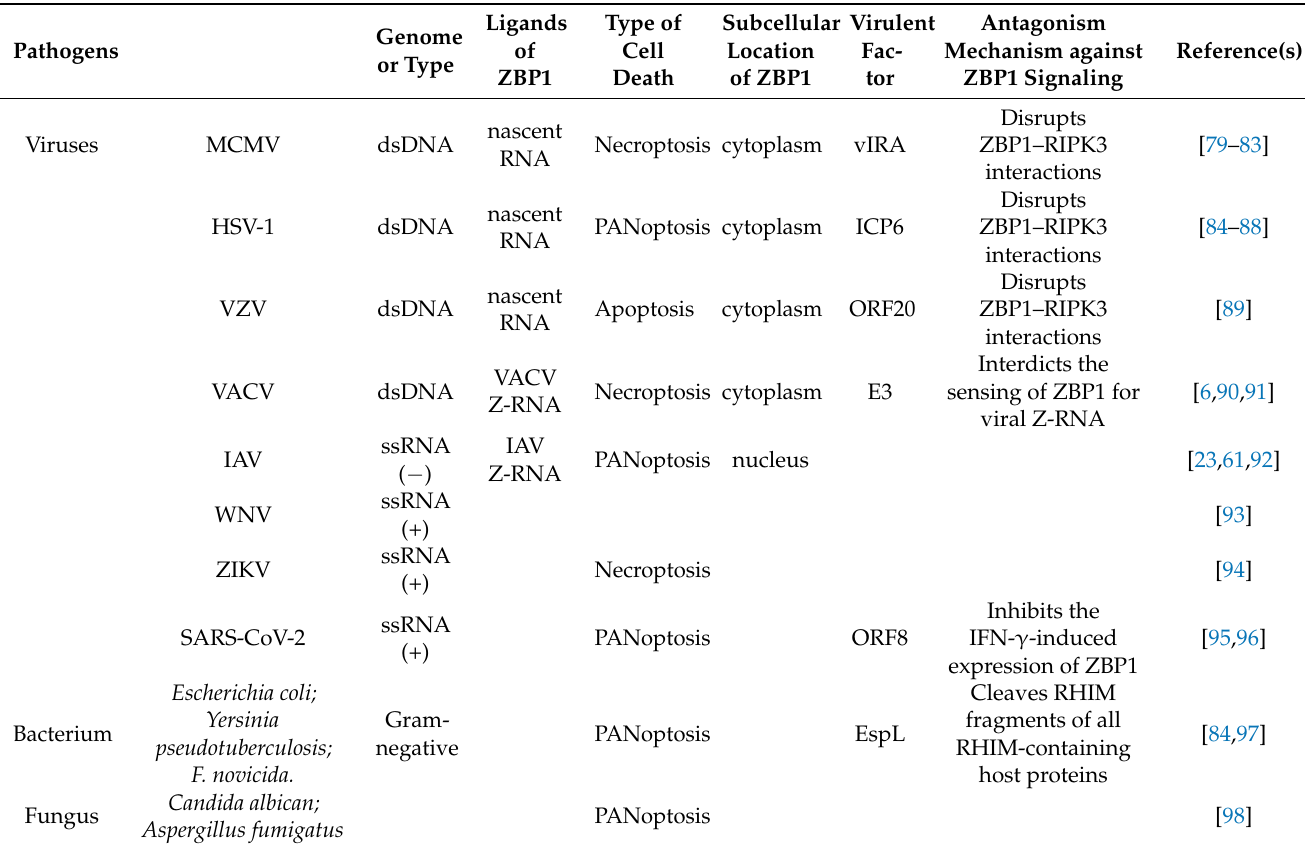
Table 1. Programed cell death mediated by ZBP1 during microbial